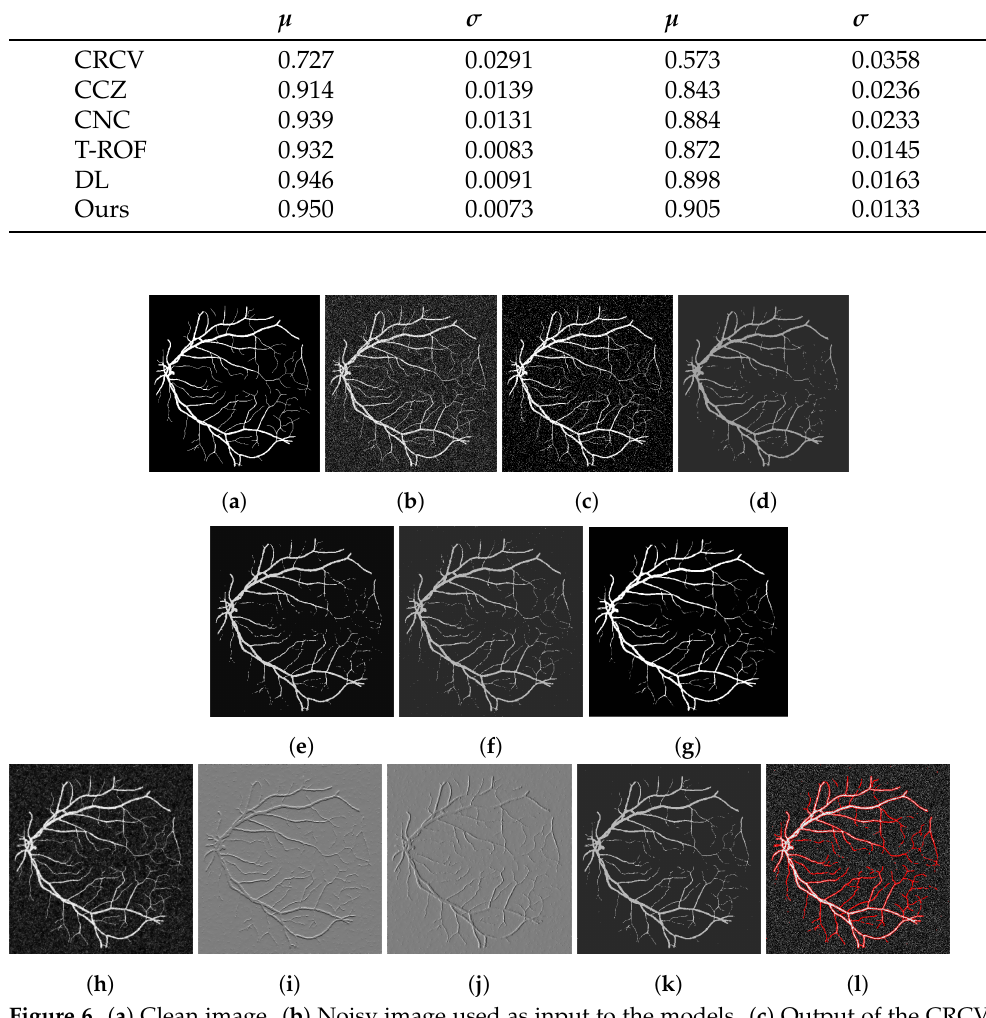
Figure 6. ( a ) Clean image. ( b ) Noisy image used as input to the models. ( c ) Output of the CRCV model. ( d ) CCZ after thresholding. ( e ) CNC after thresholding. ( f ) T-ROF after thresholding. ( g ) DL output. ( h ) Output g of our model. ( i ) Output G x of our model. ( j ) Output G y of our model. ( k ) Ours after thresholding. ( l ) Our